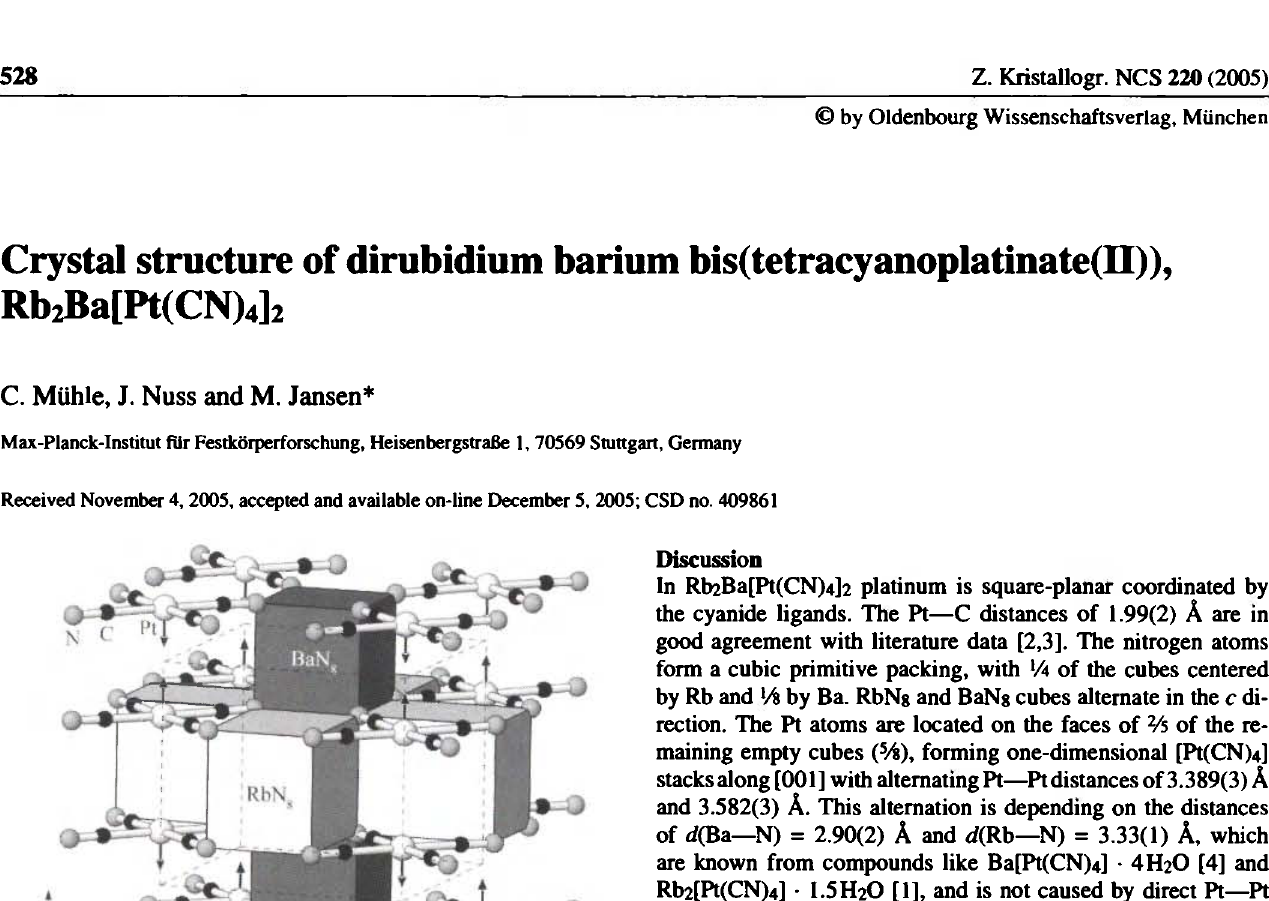
Table 1. Data collection and